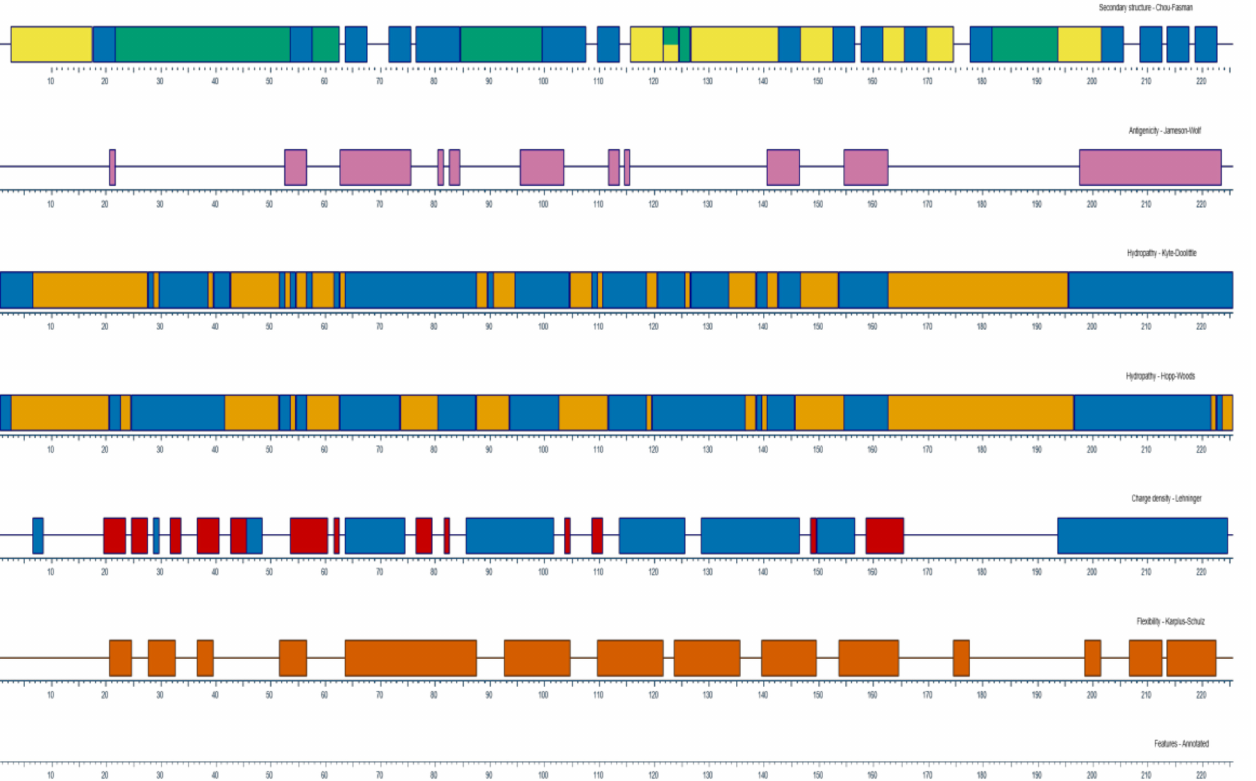
Figure 1. The properties of CD8 α molecules analyzed from DNAStar Protean program. The secondary structure, antigenicity, hydrophobicity, charge density and flexibility are represented. Pink, High antigenicity; Blue, Hydrophilic region; Orange, Hydrophobic